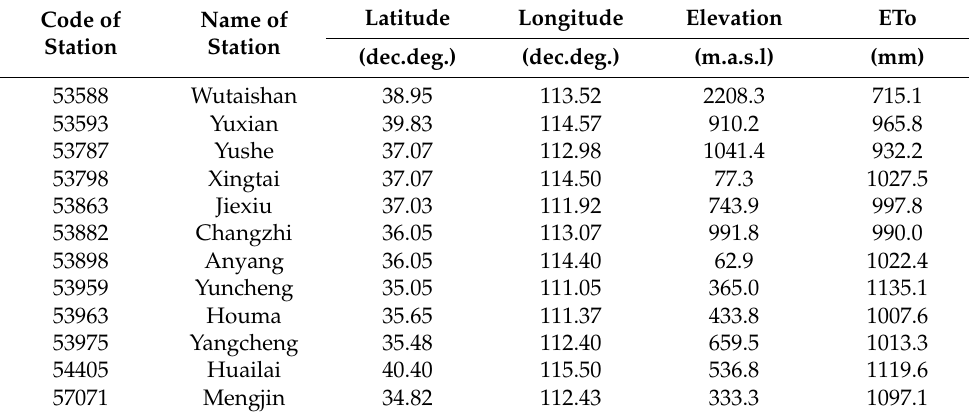
Table 1. Basic information for the meteorological stations in the